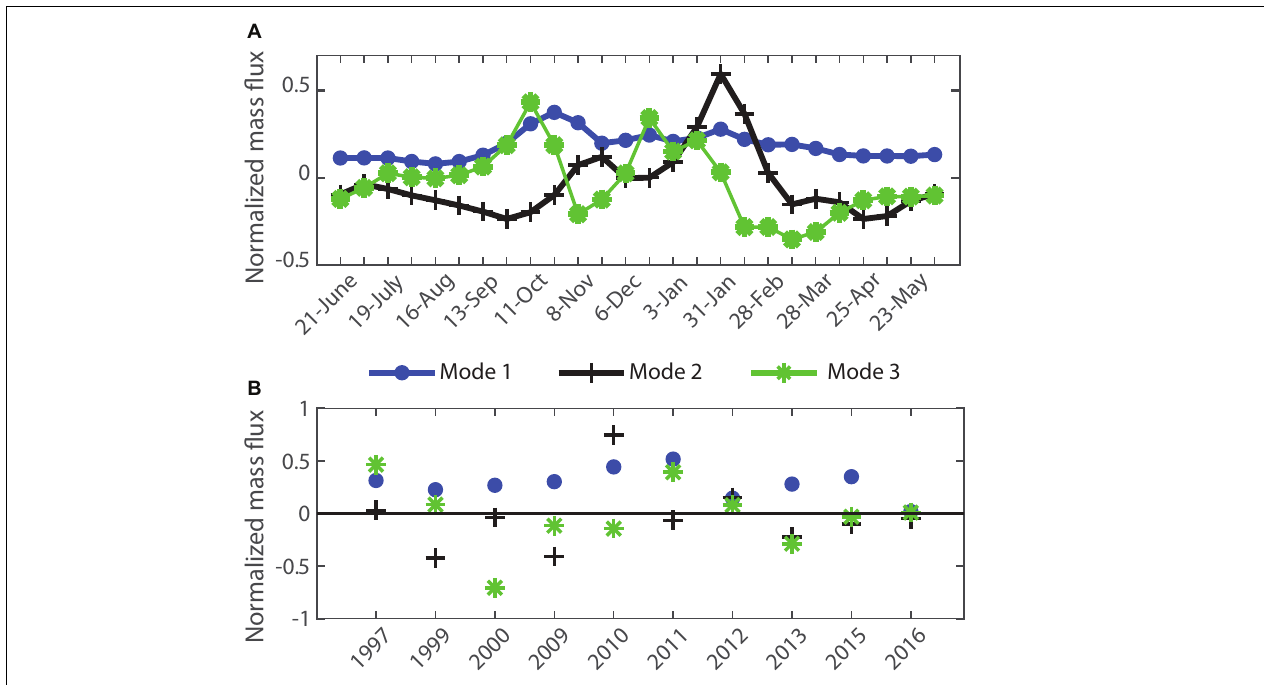
FIGURE 9 | Singular Value Decomposition for mass flux at 1000 m (A) Seasonal structure of Modes 1 – 3. (B) Interannual time series of the principal component coefficients of Modes 1–3. The % variance explained by these Modes was 79, 8, and 5%,